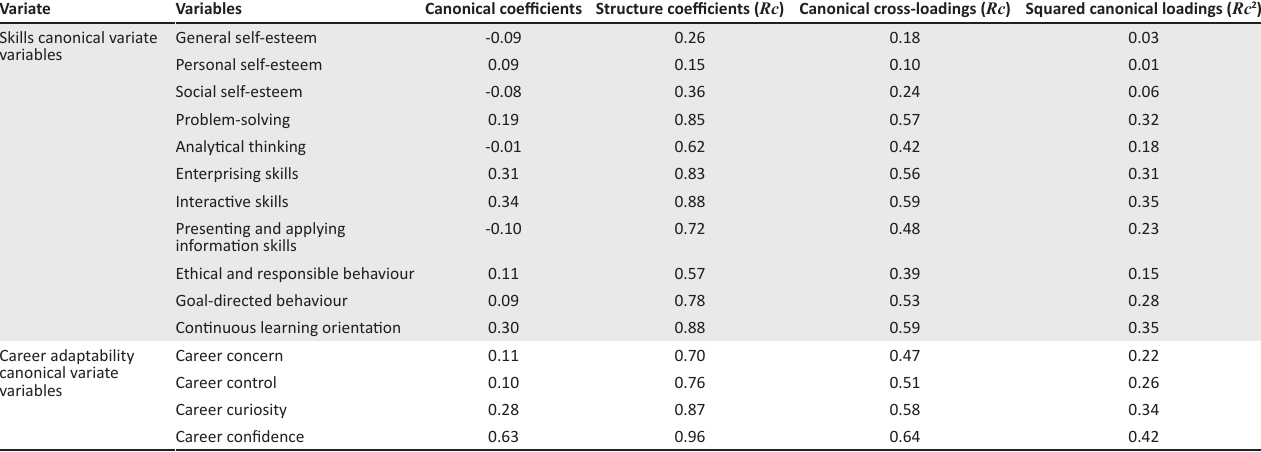
TABLE 2: Results of the standardised canonical correlation analysis for the first canonical function with the detailed graduateness skills and attributes scale variables. Variate Variables Skills canonical variate